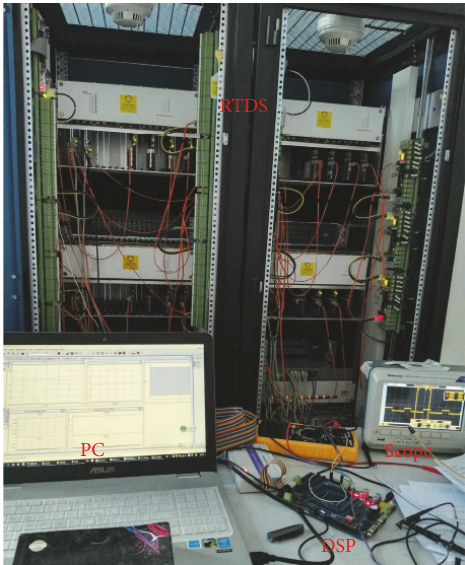
Figure 8: Photo of the HiL platform.